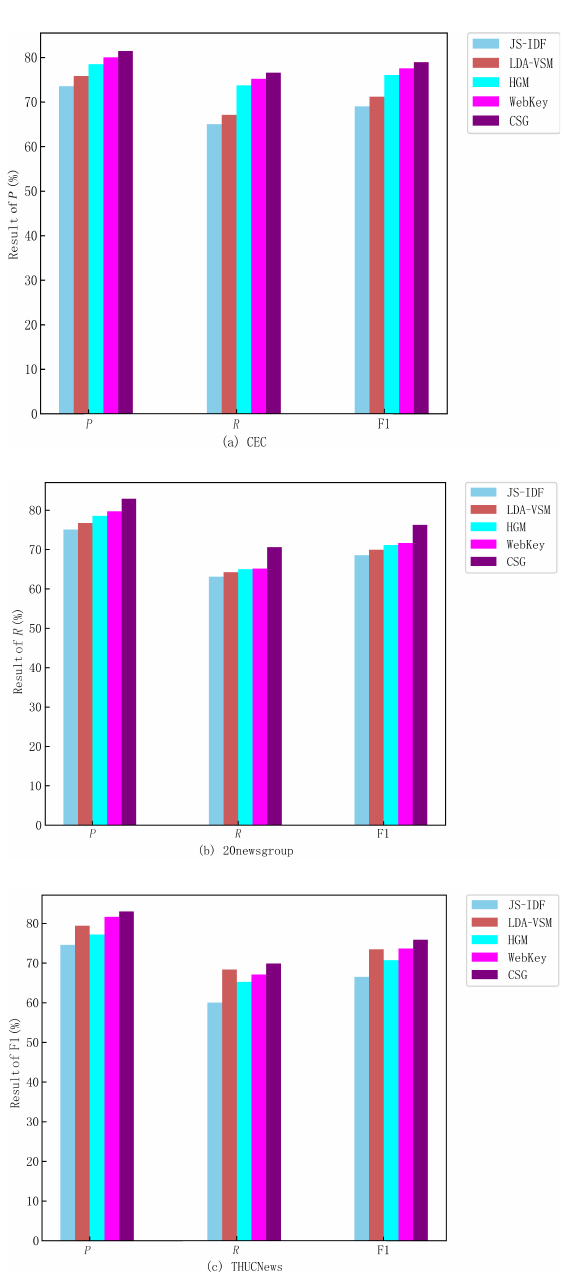
Fig. 3 Performance of different models on three datasets. (a), (b), and (c) correspond to three datasets respectively. The abscissa represents the three evaluation metrics of P , R , and F1 corresponding to the current dataset, and the ordinate represents the values of the three evaluation metrics.